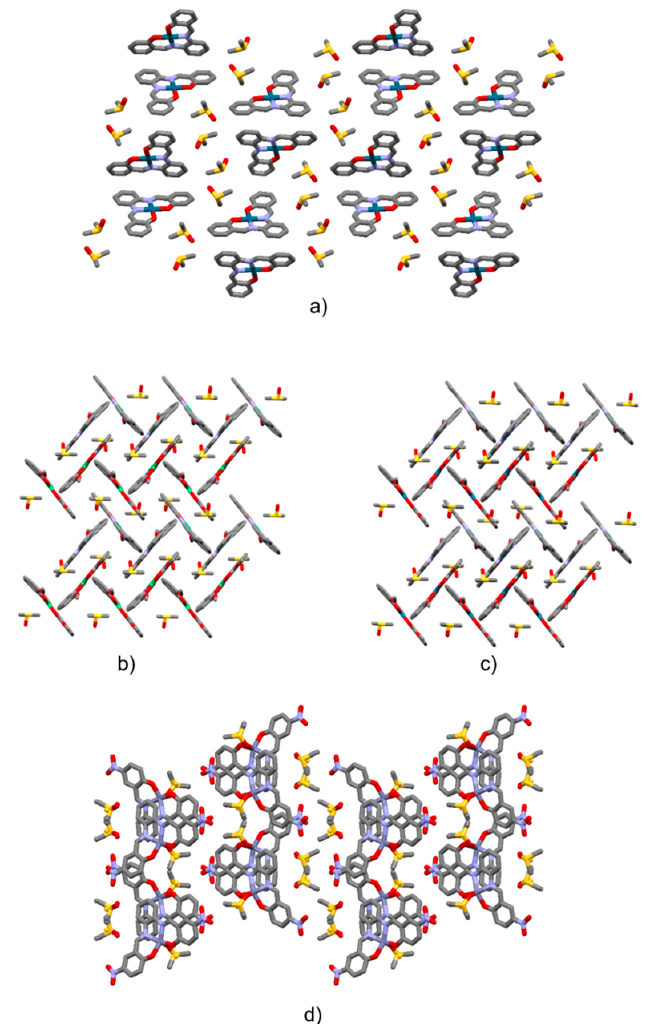
Figure 6. Crystal packing view of 1Pd . ( DMSO ) 2 ( a , view along the crystallographic b -axis); 2Ni . DMSO ( b , view along the [101] direction); 2Pd . DMSO ( c , view along the [101] direction); 3Zn(DMSO ) 2 ( d , view along the c -axis). Hydrogen atoms are omitted for